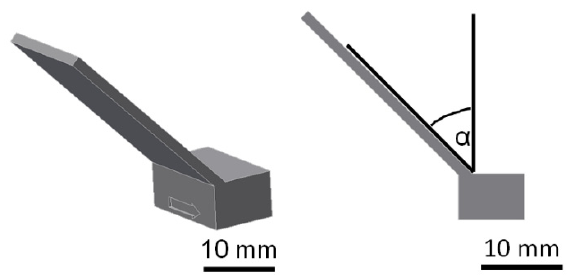
Figure 2. Overhang geometries. The angle a was varied using 5° steps.